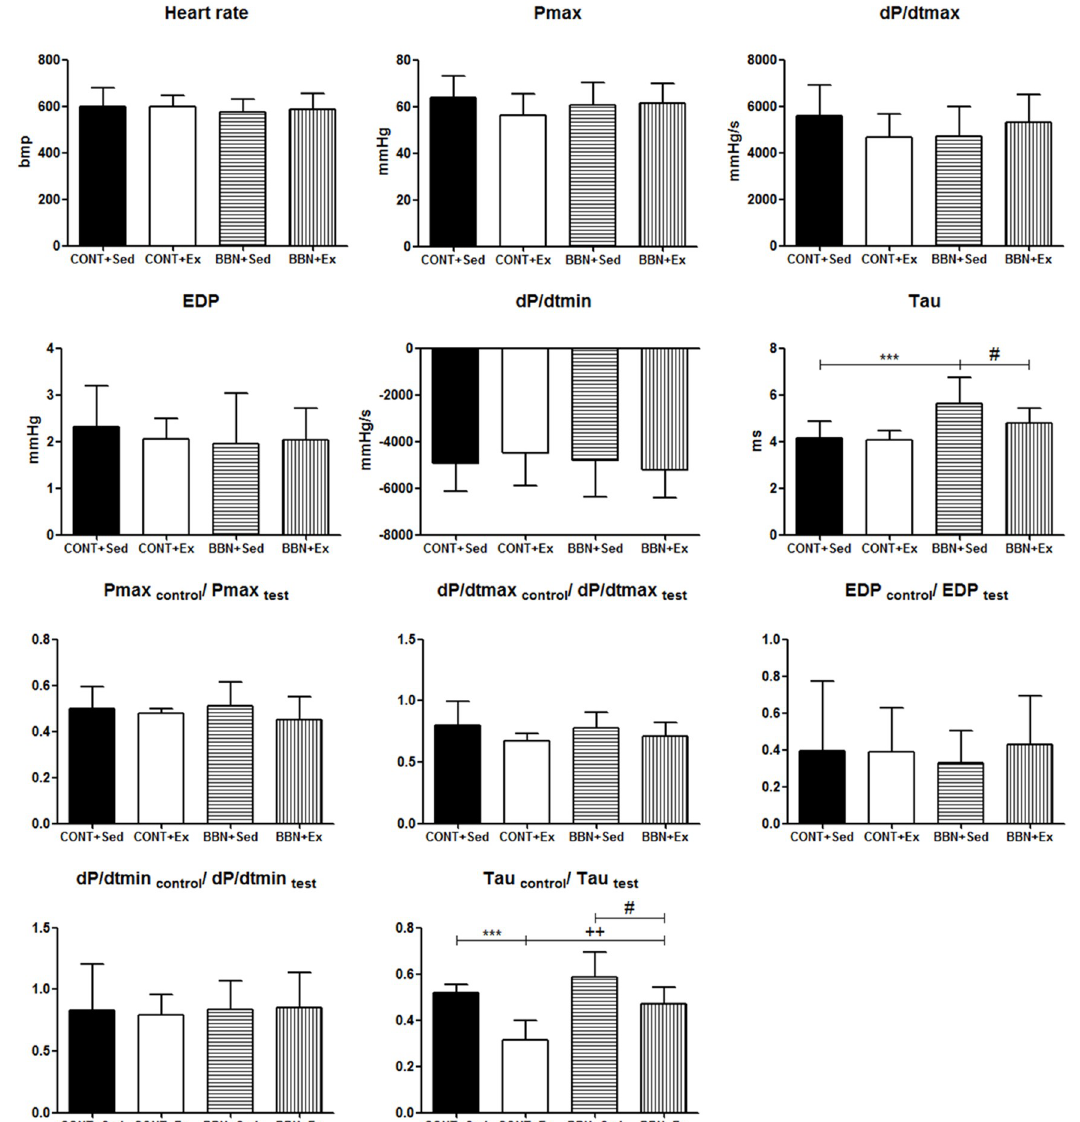
Figure 2. Effect of BBN exposure and/or exercise training on cardiac function in baseline and stress conditions: heart rate, left ventricular Pmax, dP/dtmax, EDP, dP/dtmin, Tau, Pmax control /Pmax test , dP/dtmax control /dP/dtmax test , EDP control /EDP test , dP/dtmin control /dP/dtmin test and Tau control /Tau test . Pmax, maximum pressure; dP/dtmax, peak rate of pressure rise; dP/dtmin, peak rate of pressure fall; EDP, end-diastolic pressure; Tau, time constant of ventricular pressure decay. Values are expressed as mean ± standard deviation of n = 15 for BBN groups and n = 7 for CONT groups (*** p < 0.001 vs. CONT+Sed; ++ p < 0.01 vs. CONT+Ex; # p < 0.05 vs. BBN+Sed).